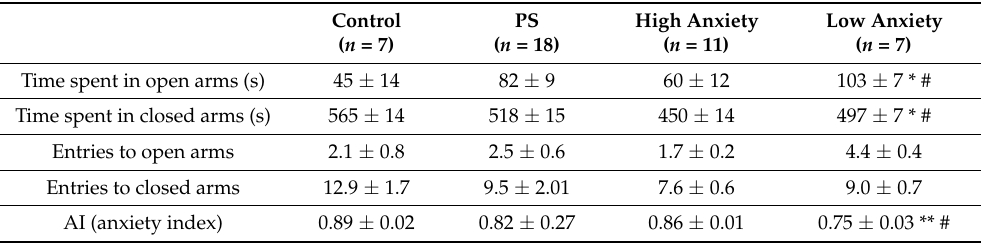
Table 1. Results of EPM behavioral experiments. Control PS High Anxiety Low Anxiety ( n = 7) ( n = 18) ( n = 11) ( n = 7) Data are the mean ± SEM. Different from control * p < 0.05, ** p < 0.01. Different from high-anxiety Time spent in open arms (s) 45 ± 14 82 ± 9 60 ± 12 103 ± 7 * # Time spent in closed arms (s) 565 ± 14 518 ± 15 450 ± 14 497 ± 7 * # Entries to open arms 2.1 ± 0.8 Entries to closed arms